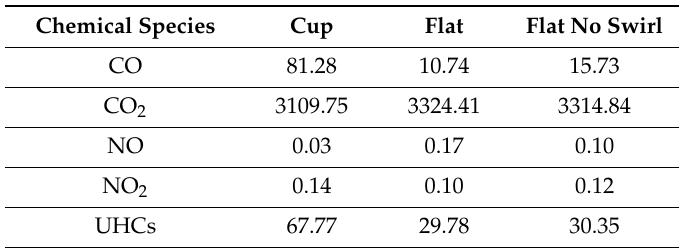
(cid:20) (cid:21) g speciesEVO . kg fuelIVC